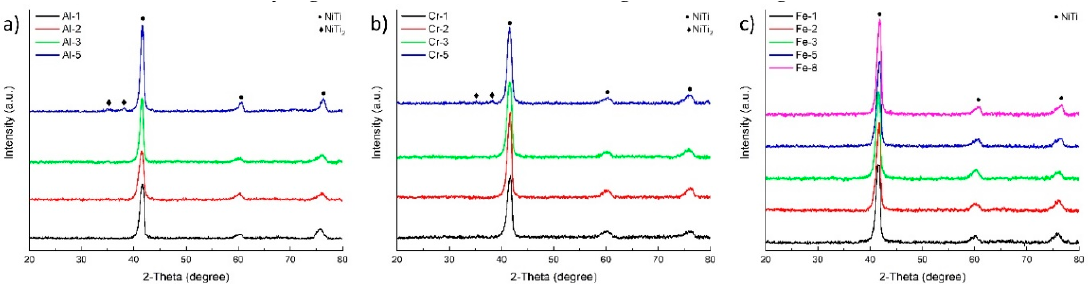
Figure 1. XRD patterns of as-cast samples: ( a ) alloys doped with Al, ( b ) alloys doped with Cr, ( c ) alloys doped with Fe.